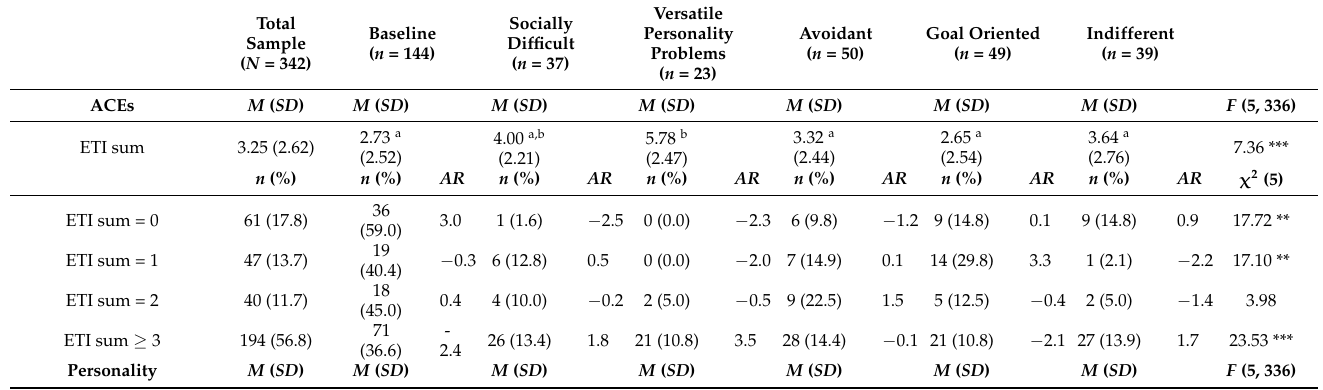
Table A1. Distribution of variables of interest in the total sample and the six personality